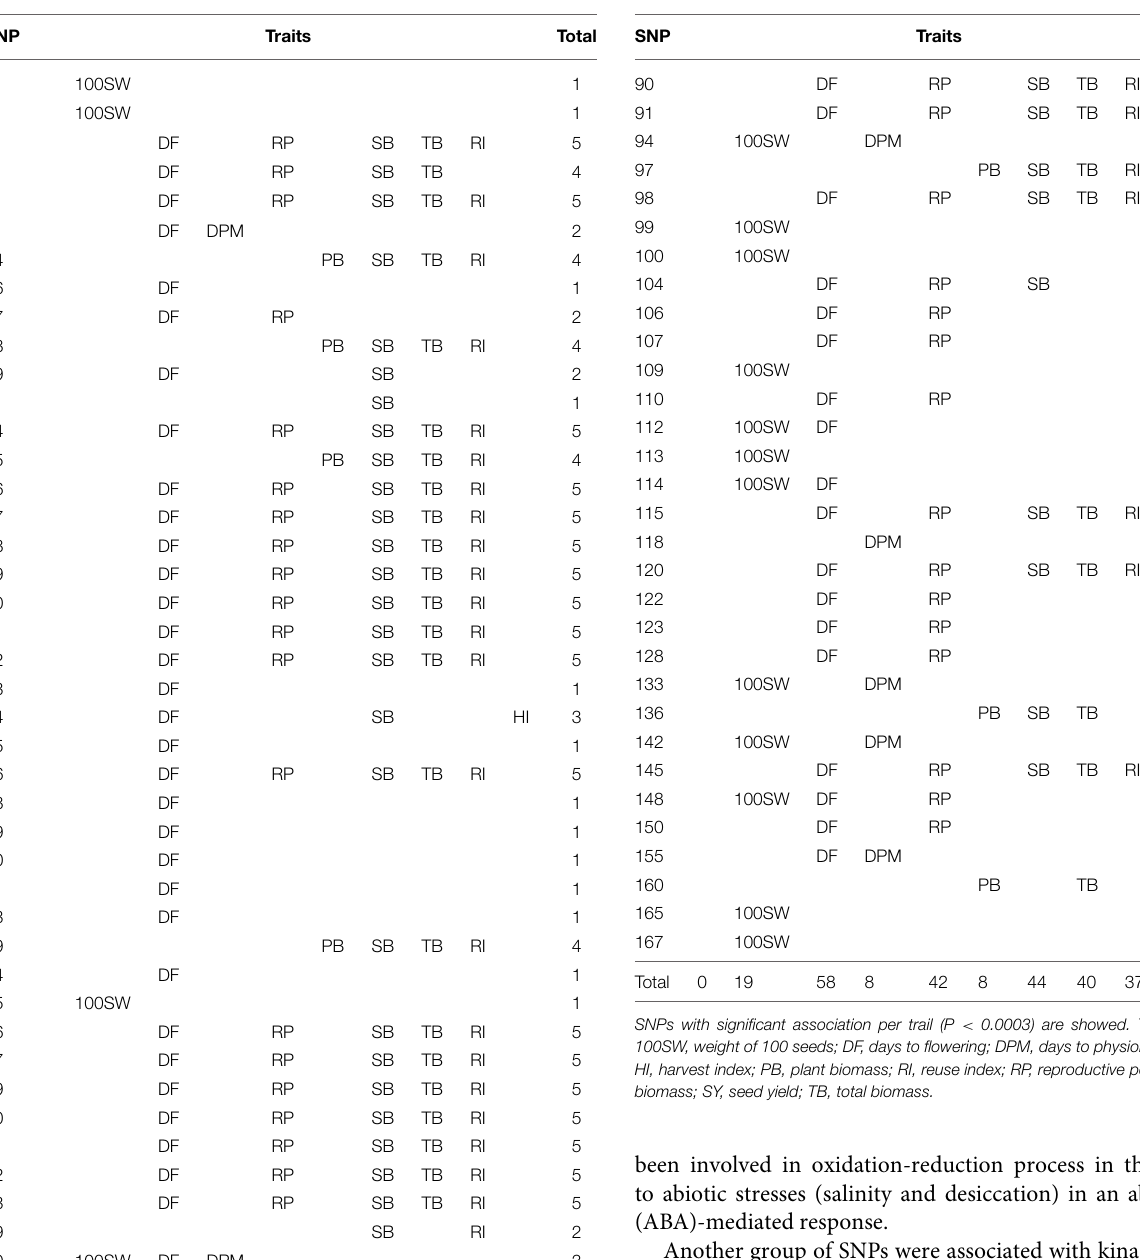
TABLE 2 | SNPs associated to